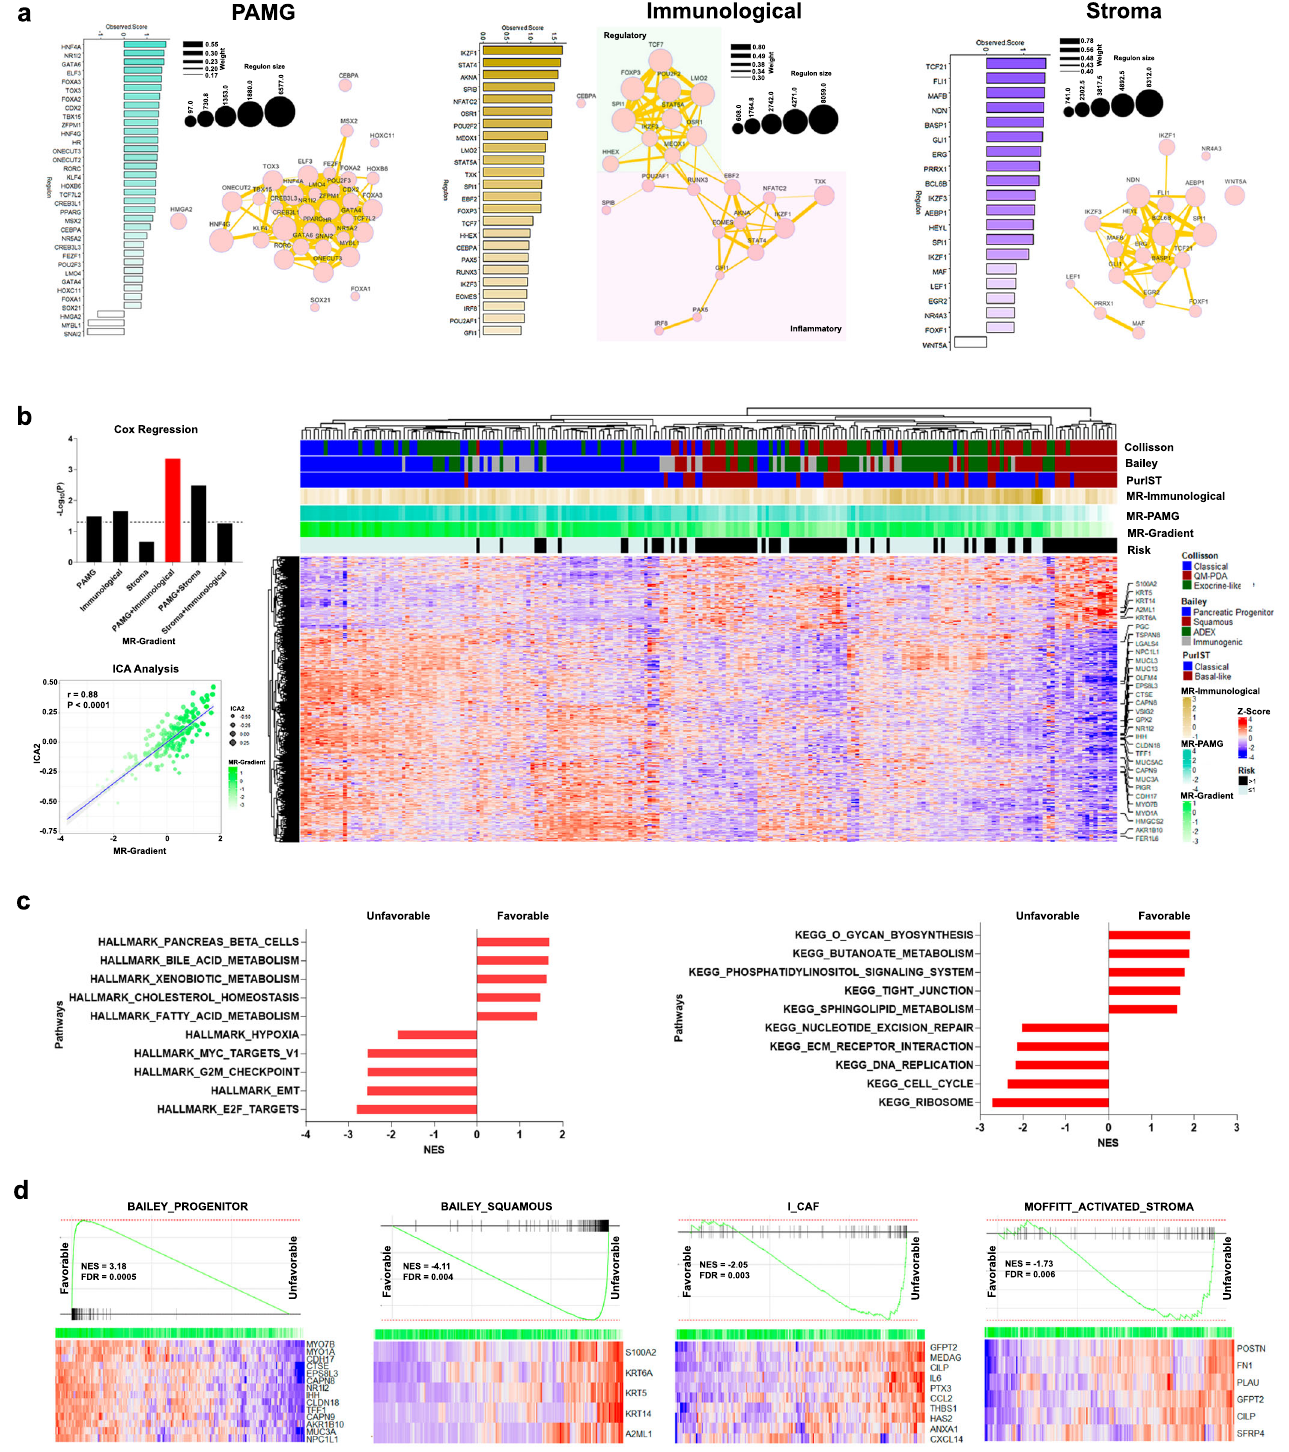
Fig. 2 Transcriptional Master Regulator (MR) gradient and tumoral phenotype characterization. a Transcriptional network and enrichment score of key regulons after regulatory transcriptional network (RTN) analysis on PAMG, immunological, and stroma components. b Univariate Cox regression Log-Rank P -value representation applying the gradients of master regulators (MR) extracted from the RTN analysis for TCGA- PAAD, and ICGC-PACA-AU Seq datasets. Moreover, the global PDAC phenotype associated to the MR-Gradient (integration of PAMG and immunological MR) was extracted using ICA. ICA2 was detected ( r = 0.88; P < 0.0001) and the high contributive genes were represented in a heatmap. c Gene-set enrichment analysis (GSEA) was applied on ICA2, detecting the pathways associated with a favorable and unfavorable prognosis. d MR-Gradient capture both tumor epithelial cell and microenvironment features, previously associated with the prognosis, such as BAILEY_PROGENITOR (NES = 3.18; FDR = 0.0005), BAILEY_SQUAMOUS (NES = − 4.11; FDR = 0.004), I_CAF (NES = − 2.05; FDR = 0.003), and MOFFITT_ACTIVATED_STROMA (NES = − 1.73; FDR =